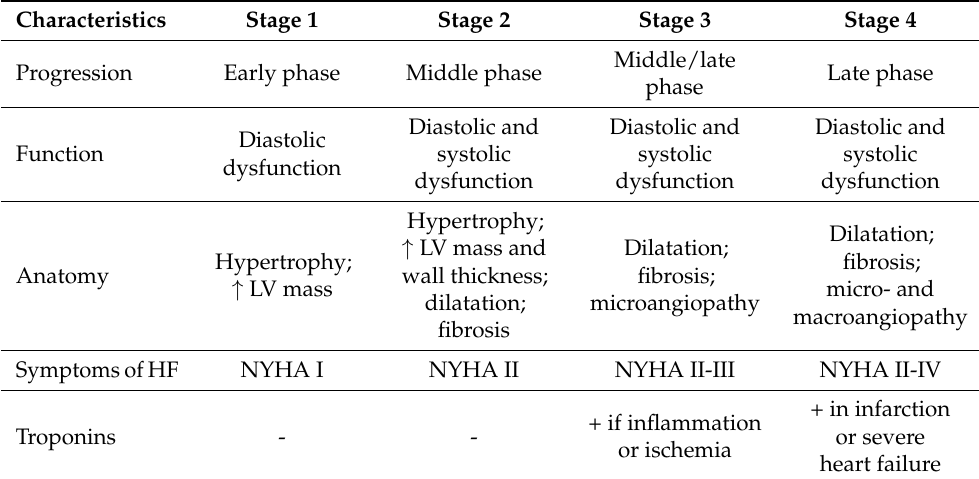
Table 1. Stages or subgroups of diabetic